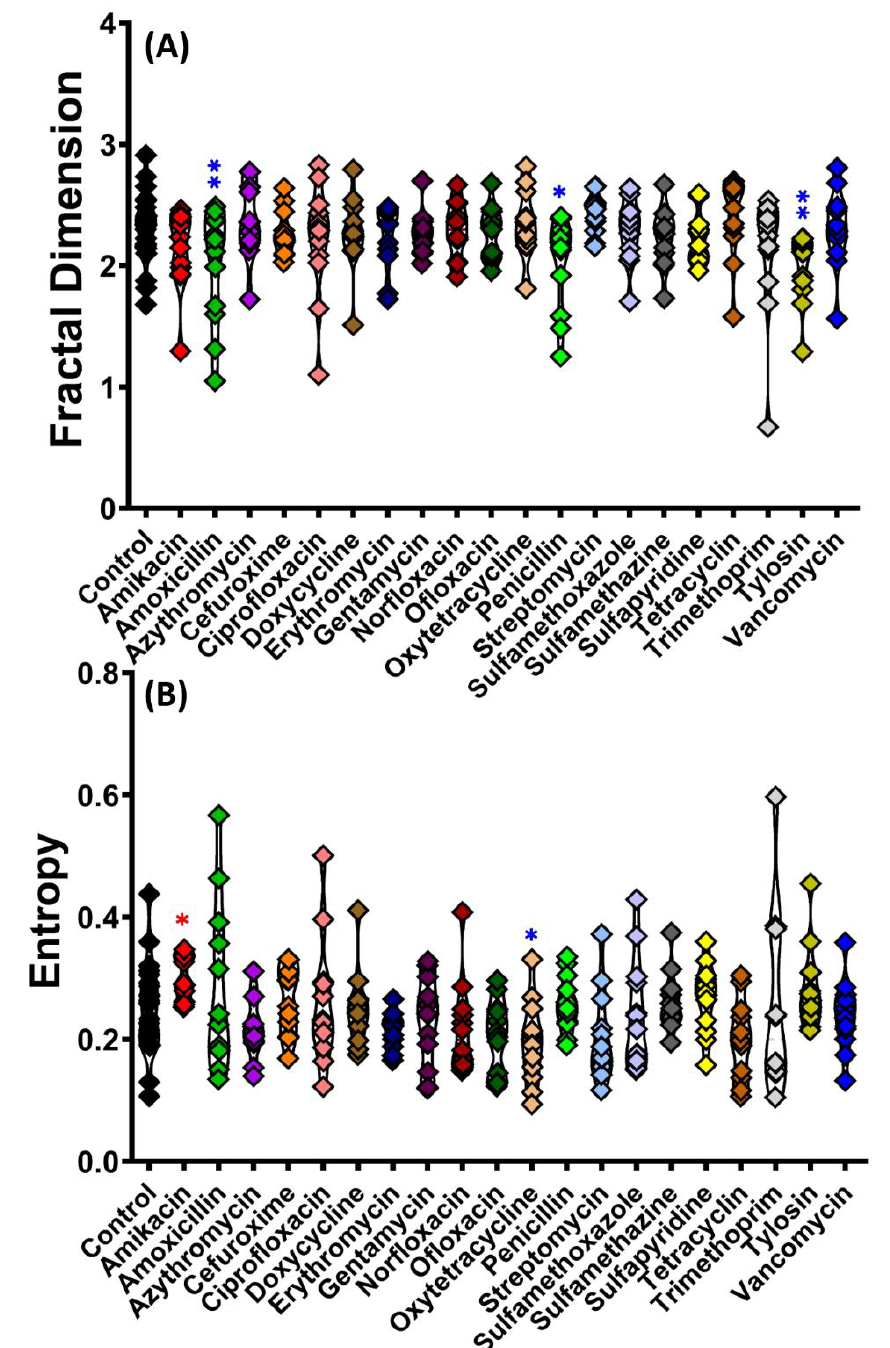
Figure 4. Comparison of ( A ) fractal dimension (FD) and ( B ) entropy value in golden zebrafish locomotion after 10 days exposure with different antibiotics in 3D locomotion test. The data were analyzed by ordinary one-way ANOVA followed by multiple comparison Fisher’s LSD test ( n control: 24, n for each antibiotic group: 12). The significances were indicated by * p < 0.05; ** p < 0.01 (red asterisk indicates a higher mean value, while blue asterisk indicates a lower mean value than control).